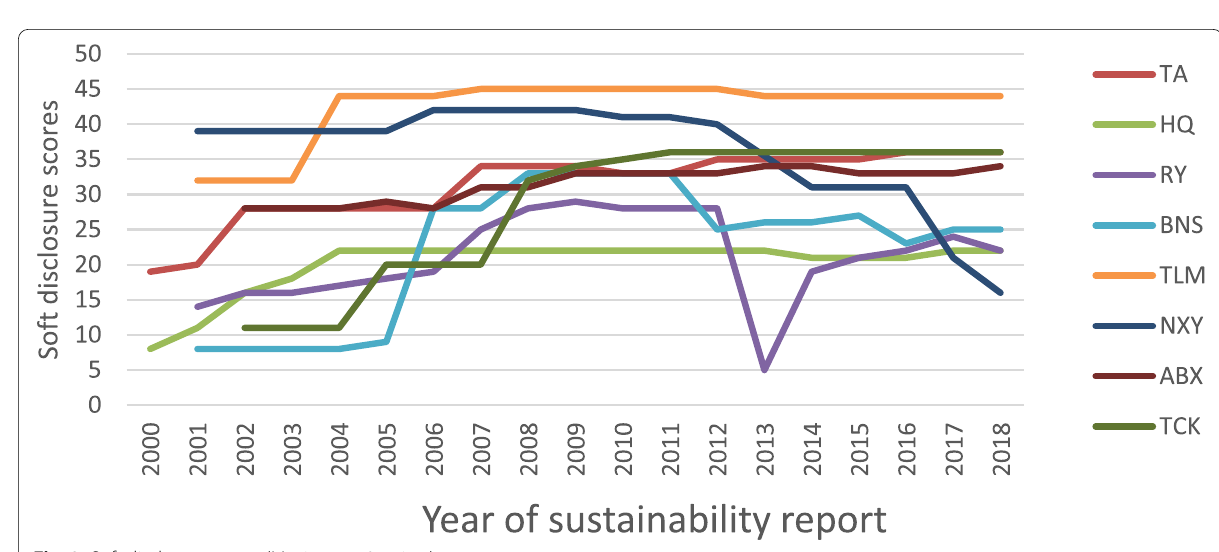
Fig. 2, the firms increased the number of hard